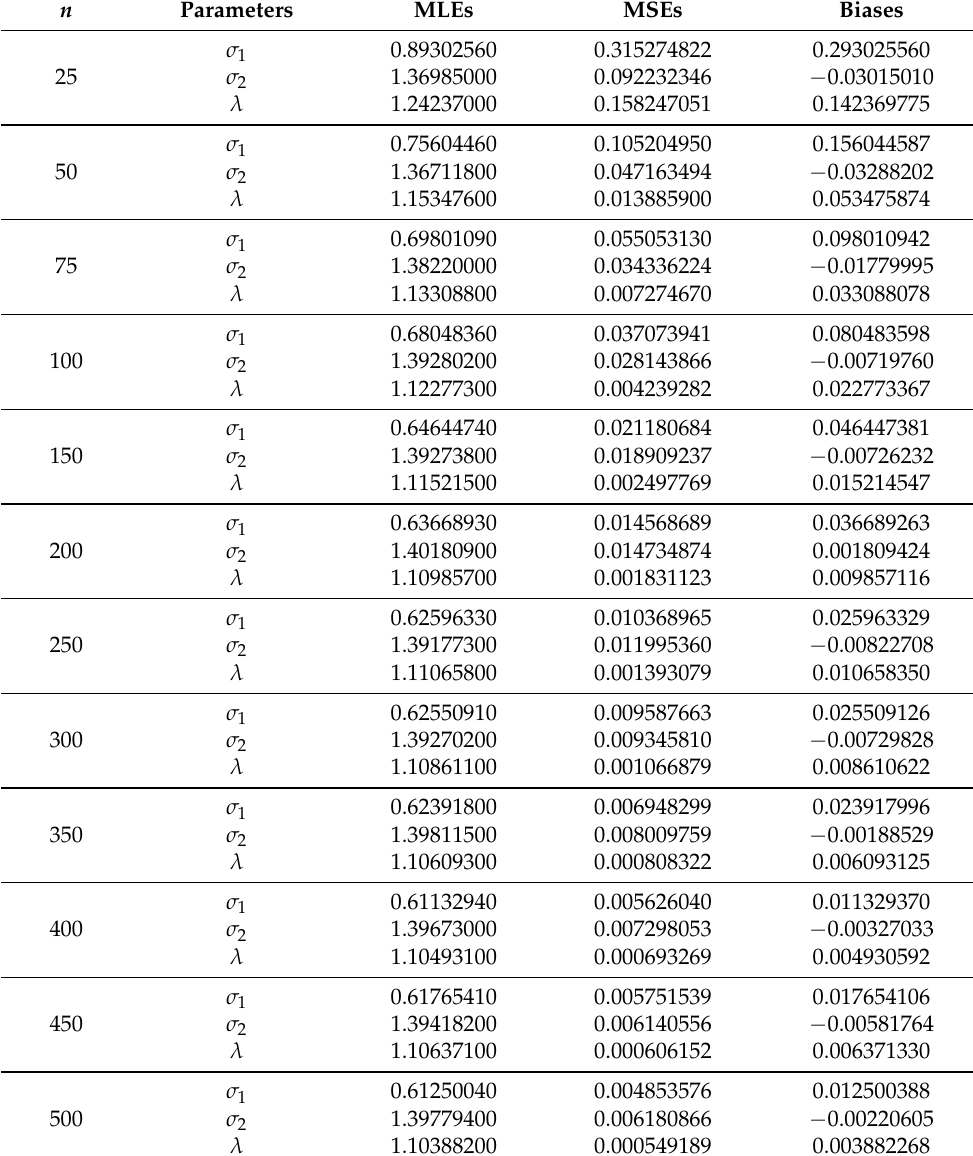
Table 1. The results of the SimS of the NMFWE model for σ 1 = 0.6, σ 2 = 1.4, and λ = 1.1.